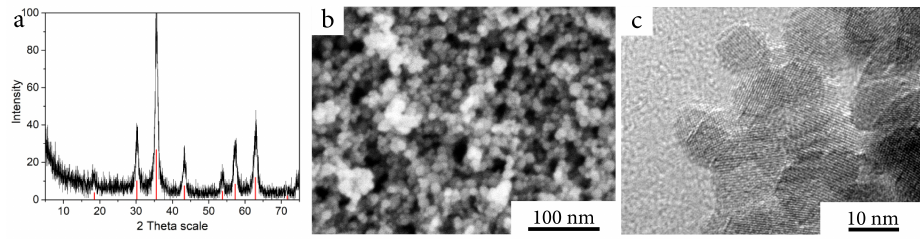
Figure 1. Magnetite nanoparticles: ( a ) XRD pattern of the synthesized material. ( b ) SEM image of the material. ( c ) TEM image of the material.